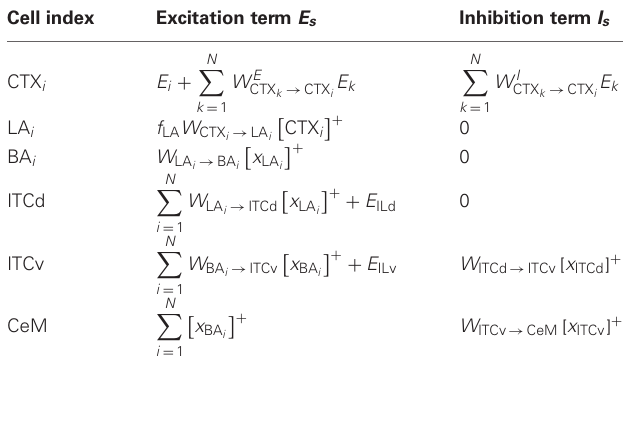
Table A1 | Excitatory and inhibitory inputs to each network component.